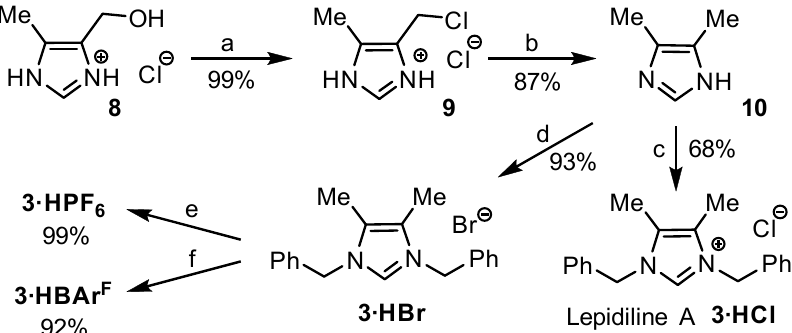
Scheme 2. Synthesis of Lepidiline A and counter-ion analogues.